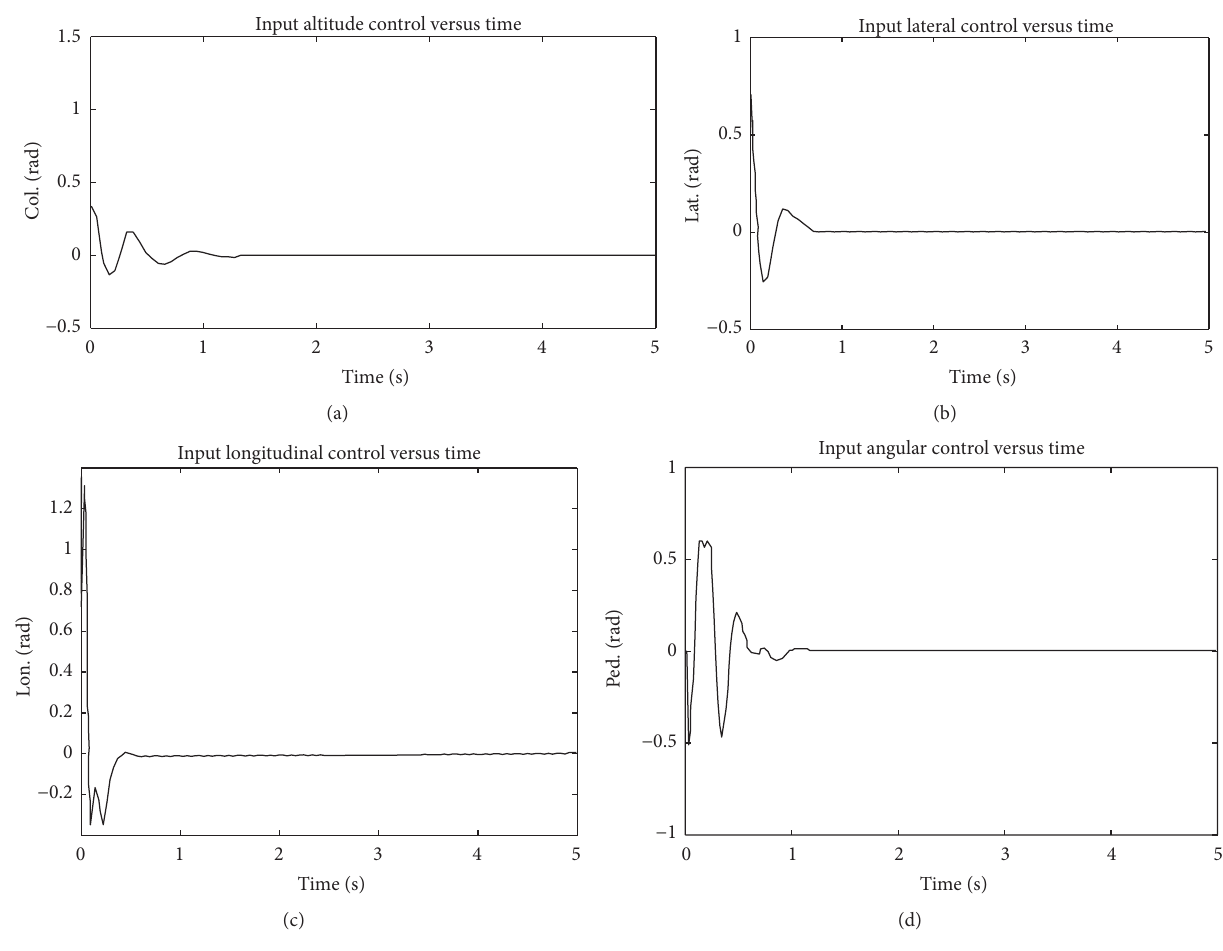
Figure 15: Control commands of trirotor UAV.